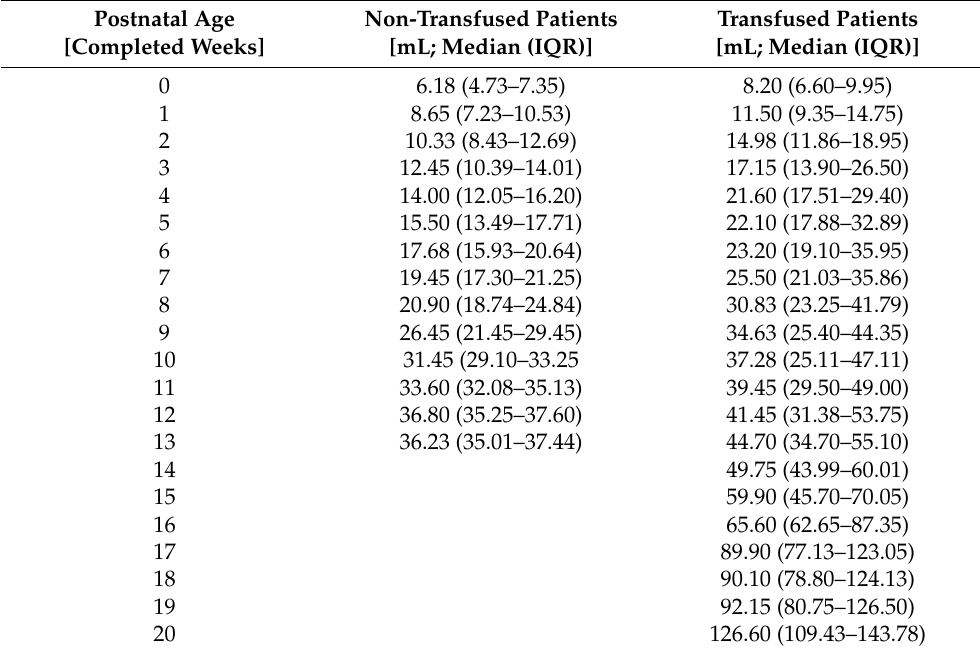
Table 3. Absolute cumulative blood sampling volume [ n = 132 VLBW